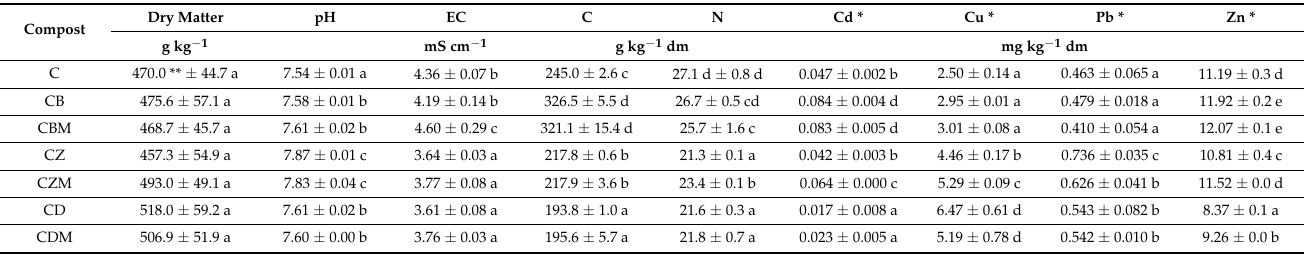
Table 3. Selected chemical properties of composts (mean ±